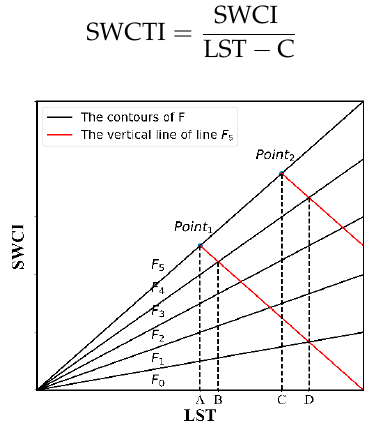
Figure 3. Contours of F.